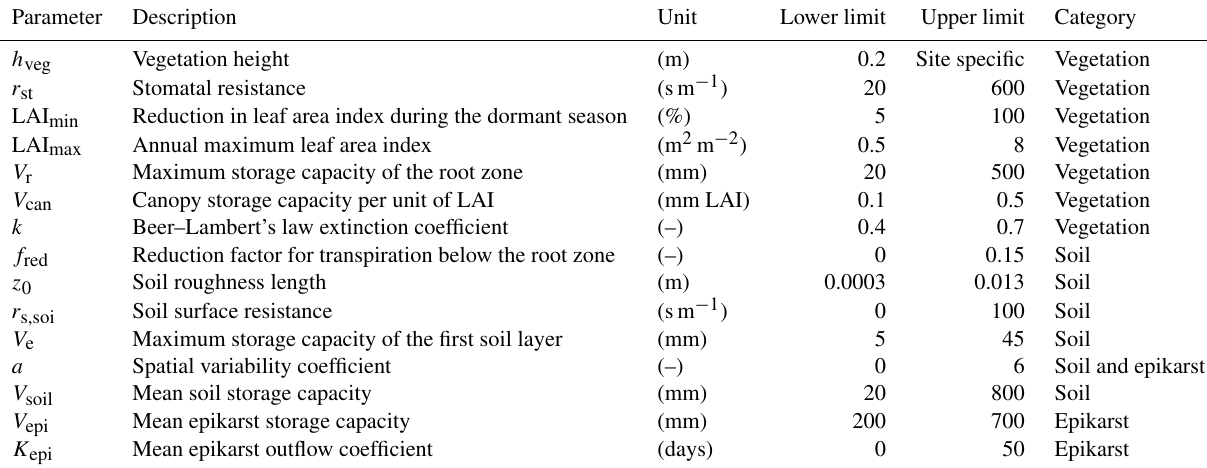
Table 1. Description of V2Karst parameters, unconstrained ranges used in the application at the four FLUXNET sites to capture the variability across soil, epikarst and vegetation types, and the category of the parameters (which indicates whether the parameters depend on soil, epikarst or vegetation properties). Parameters a , V soil , V epi and K epi were already present in the previous version of the model (VarKarst). More information on how the ranges were determined is provided in Sect. S3 of our